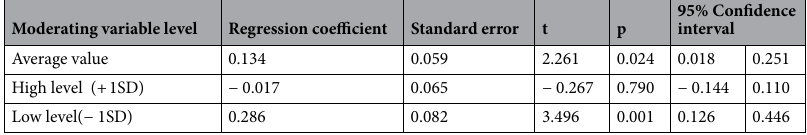
Table 9. Results from simple slope analysis of the moderating effect of job satisfaction.